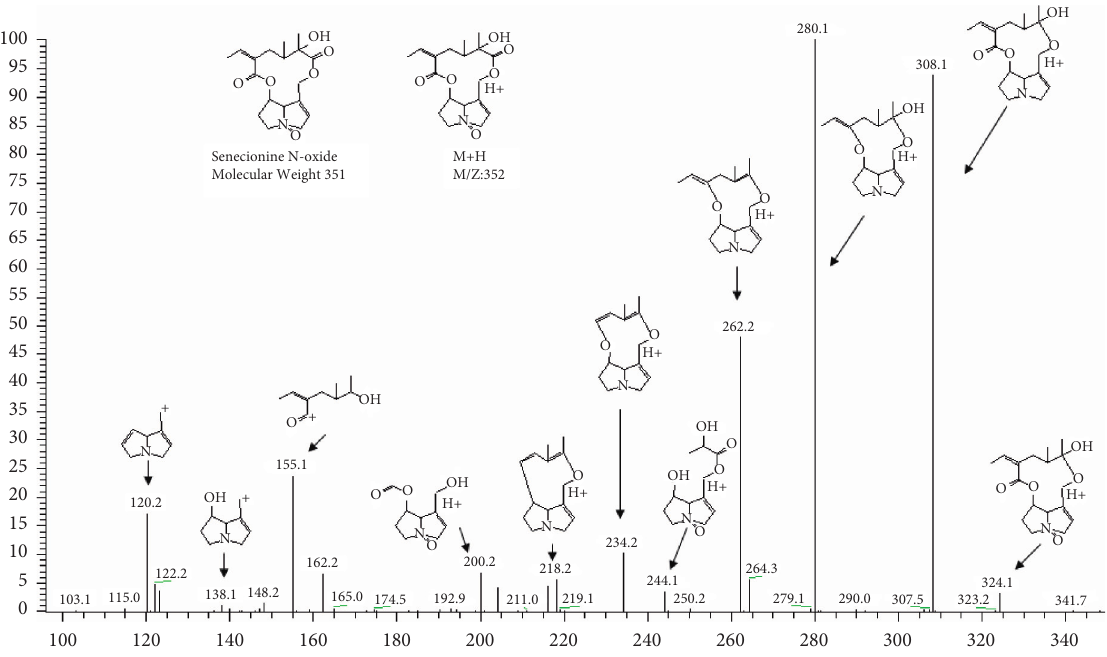
Figure 4: MS2 spectrum and fragment of compound 9: Senecionine